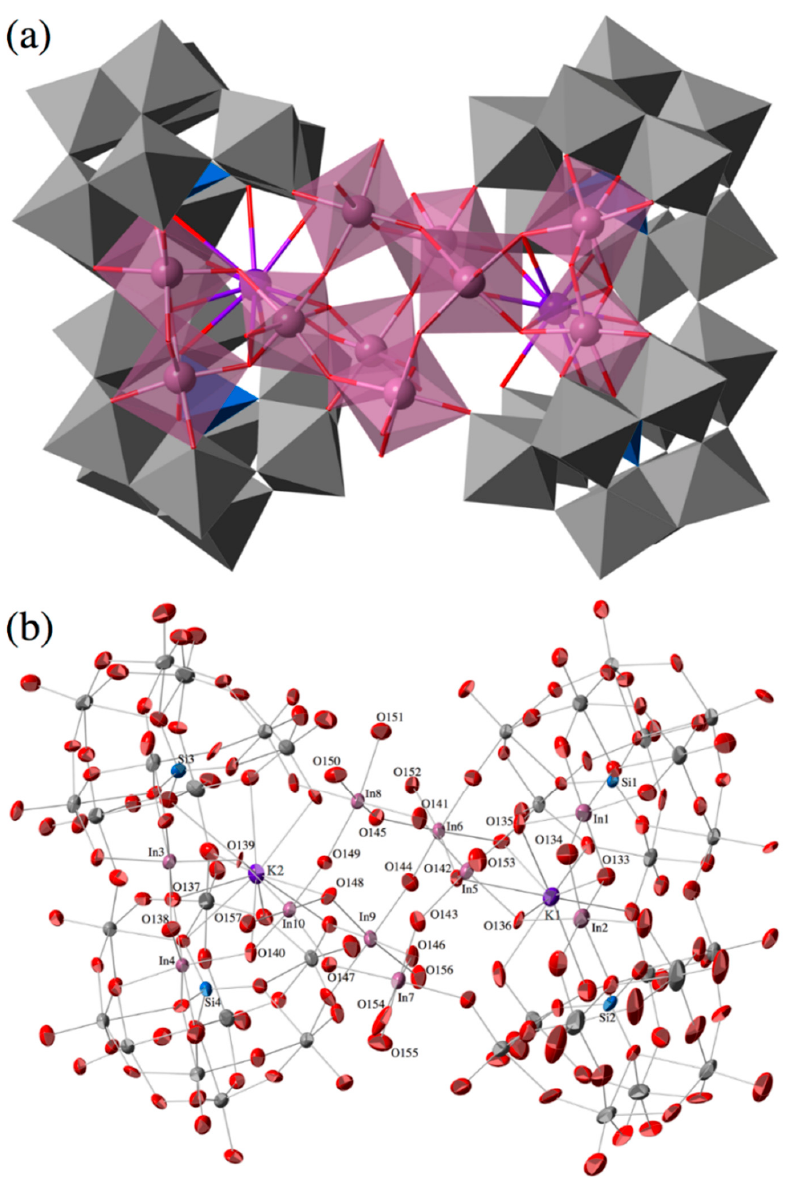
Figure 1. Molecular structure of the polyoxoanion, {[{KIn 2 ( µ -OH) 2 }( α , α -Si 2 W 18 O 66 )] 2 [In 6 ( µ -OH) 13 (H 2 O) 8 ]} 17 − of potassium salt of In 10 -open . ( a ) Its polyhedral representation; and ( b ) thermal ellipsoidal plot. Color code: In, pink; K, purple; O, red; Si, blue; W, gray. The two indium atoms in the open pocket of the open-Wells–Dawson POM units are connected through edge-sharing oxygen atoms (O133, O134 for In1, In2; O137, O138 for In3, In4) with In···In distances of 3.266(2) (In1···In2) and 3.299(2) (In3···In4) (Figure 2a). Each Indium atom in the open